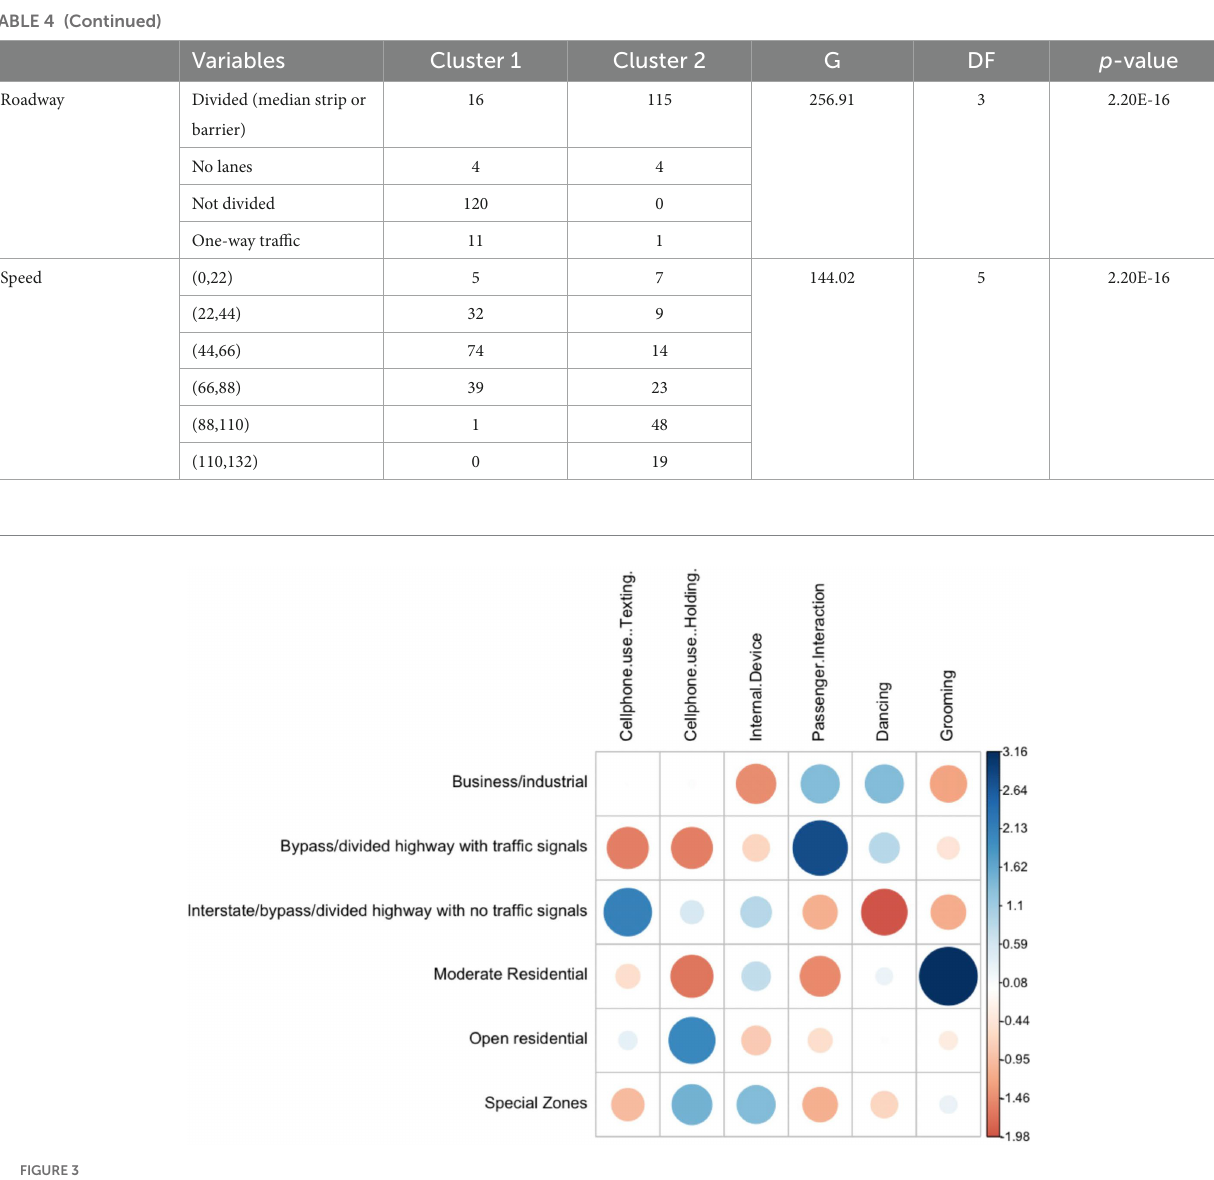
FIGURE 3 Pearson residuals for locality and secondary task